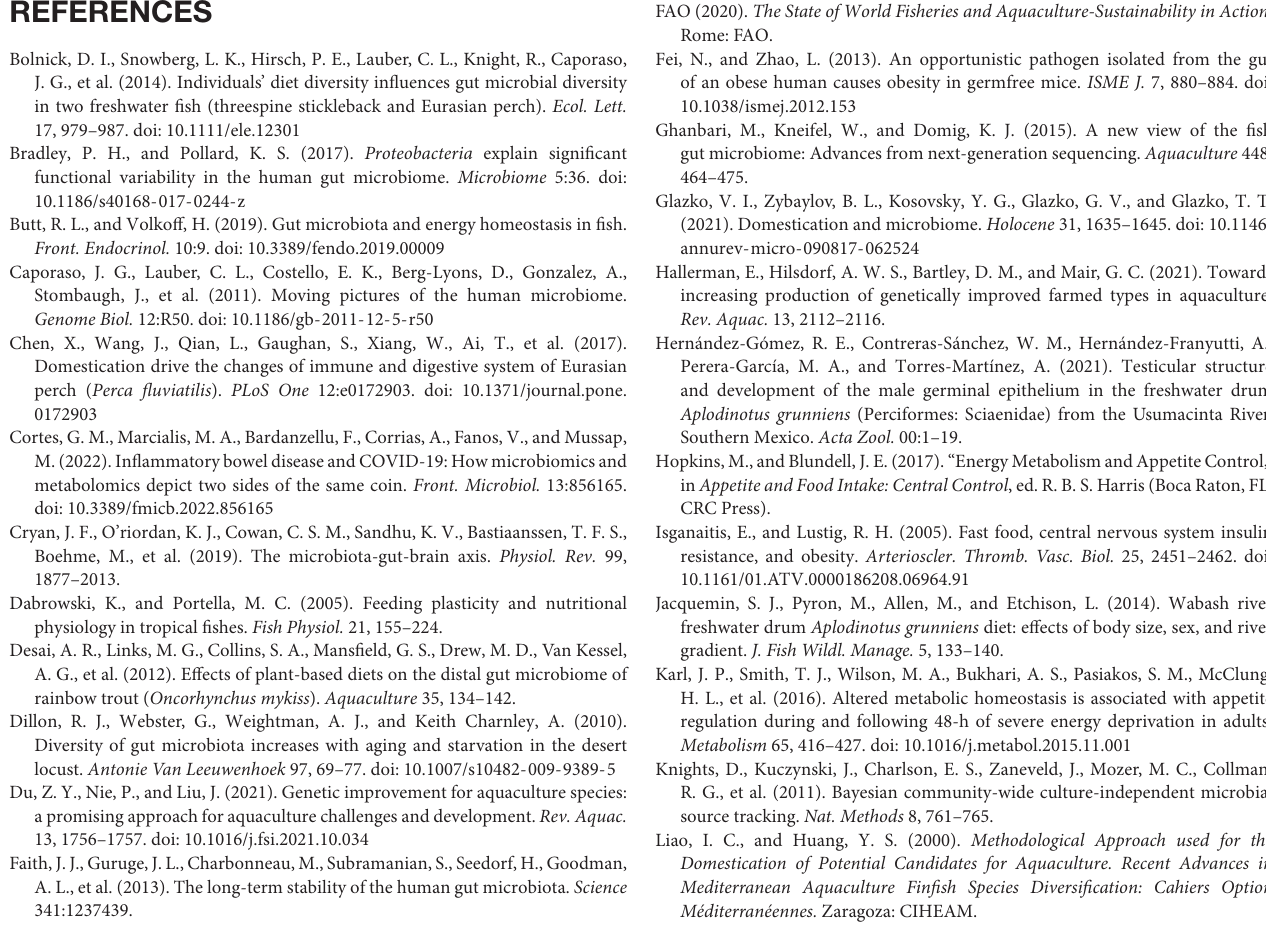
Supplementary Table 1 | Differentially expressed genes (DEGs) under feed domestication in A. grunniens intestine. (A) Upregulated DEGs; (B) downregulated DEGs. Transcripts with | fold change| ≥ 2 and corrected P -value < 0.05 were identified as DEGs. Supplementary Table 2 | GO and KEGG enrichment of DEGs under feed domestication in A. grunniens intestine. (A) GO items of DEGs; (B) KEGG items of DEGs. Supplementary Table 3 | Operational taxonomic units (OTUs) of the microbiota identified from the intestine of A. grunniens under feed domestication. OTUs were identified and annotated at the level of phylum, class, order, family, genus, and species, respectively. Supplementary Table 4 | Pearson analysis between DEGs and